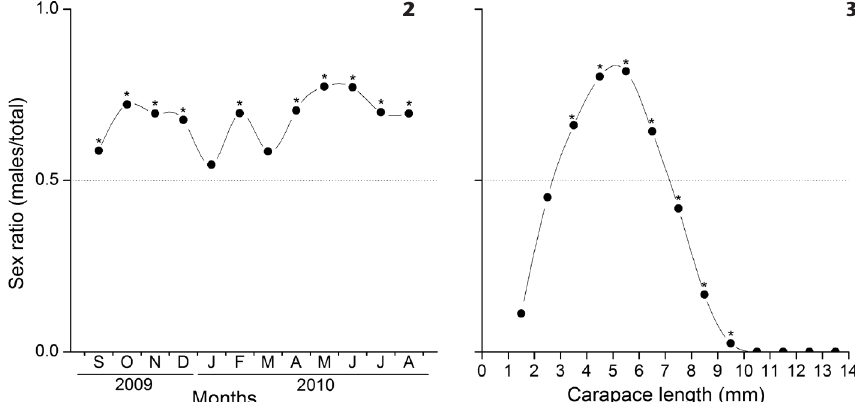
Figures 2-3. Sex ratio (male/total) of Palaemon pandaliformis collected from September 2009 and August 2010 in Rio Salsa, Canavieiras, Bahia, Brazil. (2) Monthly fluctuations. (3) Anomalous probability curve derived from a year sampling collection. * Statistically significant at p ≤